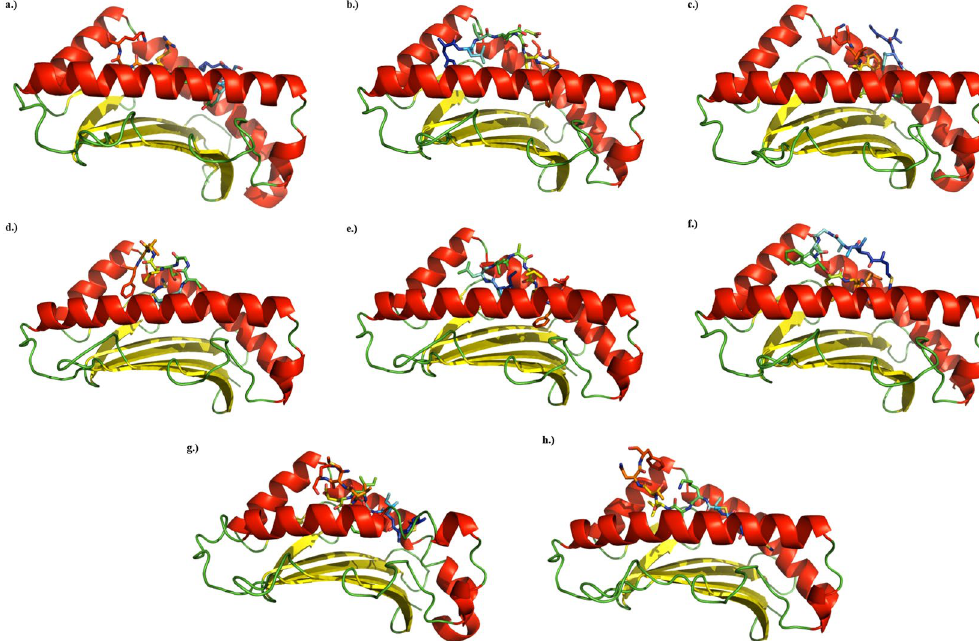
Figure 3. Top PatchDock predictions of epitope binding to MHC class I alleles as rendered by PyMOL Molecular Graphics System. Epitopes are shown as sticks with rainbow coloring (blue to red, N-terminus to C-terminus). HLA allele binding grooves are shown as cartoon with β -sheets in yellow, α -helices in red, and loops in green. DENV4 peptide KMSPGYVLGV did not bind within the binding groove of HLA-A * 02:01 in any of the top ten PatchDock predictions. ( a ) ZIKV peptide KSYFVRAAK bound to HLA-A * 03:01. ( b ) ZIKV peptide FLVEDHGFGV bound to HLA-A * 02:01. ( c ) ZIKV peptide GVFHTSVWLK bound to HLA-A * 03:01. ( d ) DENV1 peptide MLMTGTLAVF bound to HLA-A * 02:01. ( e ) DENV2 peptide ILLVAVSFV bound to HLA-A * 02:01. ( f ) DENV3 peptide MIAGVFFTFV bound to HLA-A * 02:01. ( g ) DENV peptide MAIFIEEVMR bound to HLA-B * 35:01. ( h ) DENV peptide MMLKLVTNF bound to HLA-B *